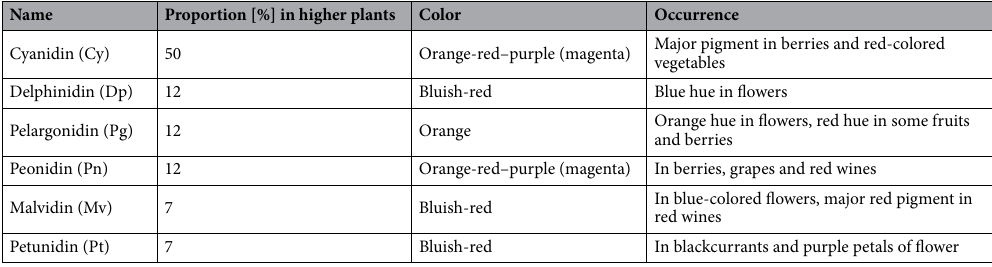
Table 7. The six most common anthocyanidins in higher plants 18,19